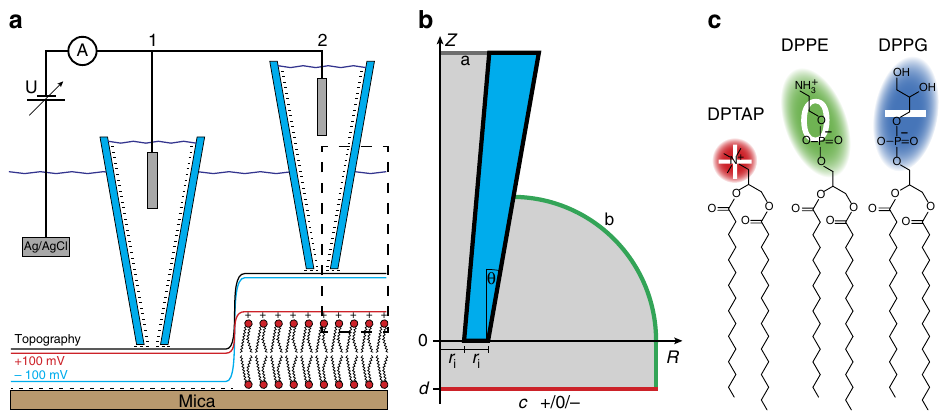
Figure 1 | Schematic of the experiment. ( a ) Schematic of the SICM setup and QSCM mode. A bias is applied between the Ag/AgCl electrodes inside the pipette and in the bath. The resulting current is affected by the distance between the pipette tip and sample surface and by the sample surface charge. The feedback keeps this current constant at 99% of the unperturbed current. This leads to a charge dependent tip–sample distance. In situation 1, the sample is negatively charged mica, while in situation 2, it is the cationic lipid DPTAP. The red (blue) line represents the path of the pipette tip at þ 100mV ( (cid:2) 100mV) bias potential. The black line represents the path taken had the sample been uncharged. The dashed box indicates the tip–sample region investigated with FEM simulations. The simulation geometry ( b ) is created with rotational symmetry along the pipette axis to reduce the three-dimensional problem to 2D. One electrode, a is positioned at the top of the pipette, the other, b is the outer edge of the water bath. The charged sample, c is positioned at a variable distance d from the tip of the pipette. The tip itself is characterized by its inner radius r i and an opening angle y . ( c ) The lipids used in the experiments are DPTAP ( þ 1 charge) DPPE (neutral) and DPPG ( (cid:2) 1